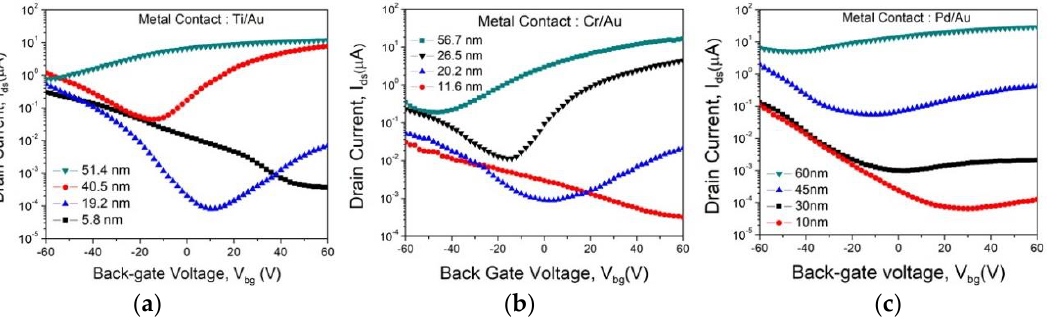
Figure 3. Transfer characteristics at V ds = 2V of TeCl 4 -grown and MoTe 2 FETs with different channel thickness for ( a ) Ti/Au; ( b ) Cr/Au, and ( c ) Pd/Au.